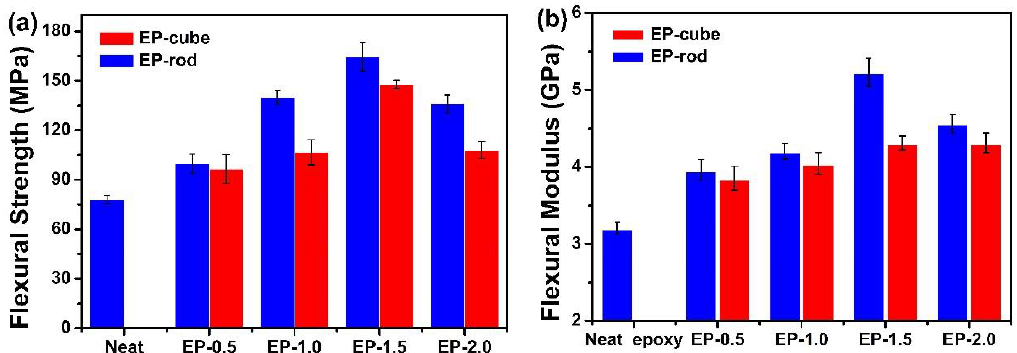
Figure 3. ( a ) Flexural strength and ( b ) elastic modulus of CaCO 3 nanocubes/epoxy composites and CaCO 3 nanorods/epoxy composites as a function of CaCO 3 content